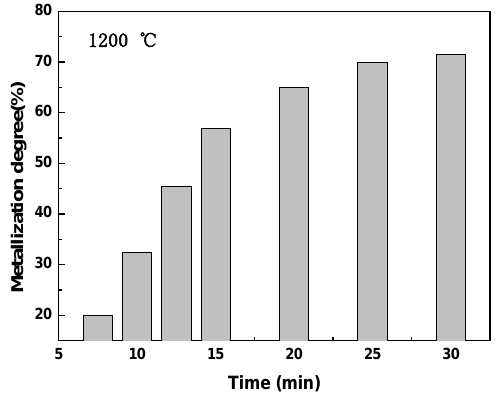
Figure 11. Metallization degree of the pellets reduced at 1200 °C.